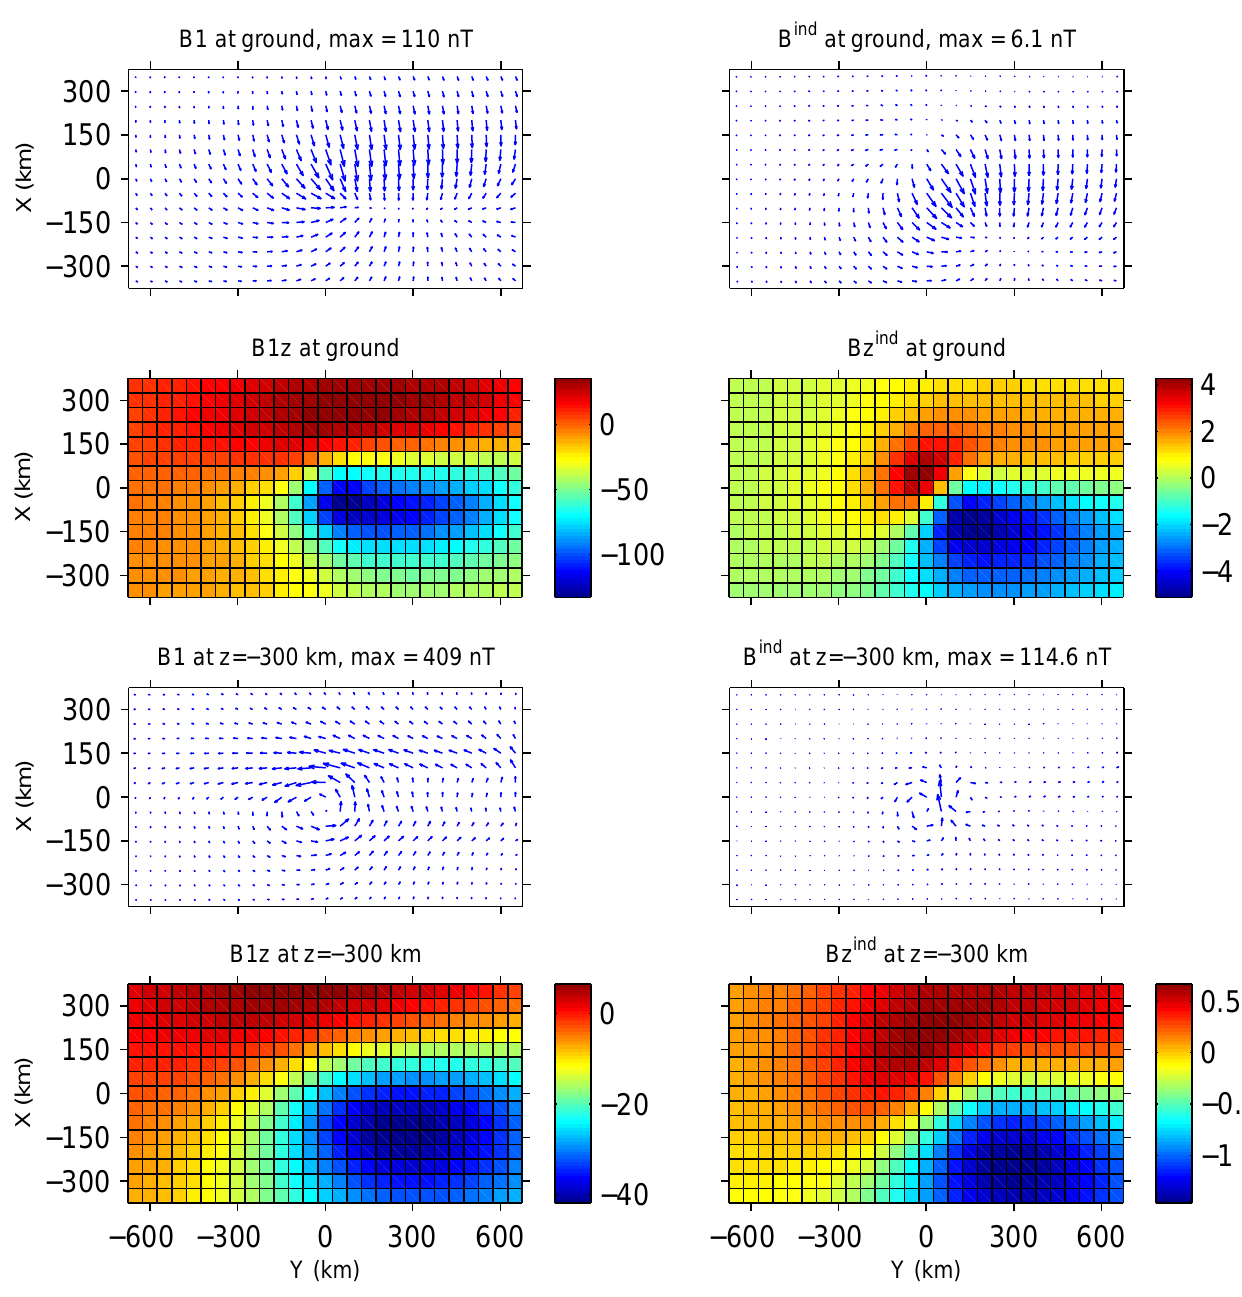
Fig. 11. Same as Fig. 7, but for the WTS model.